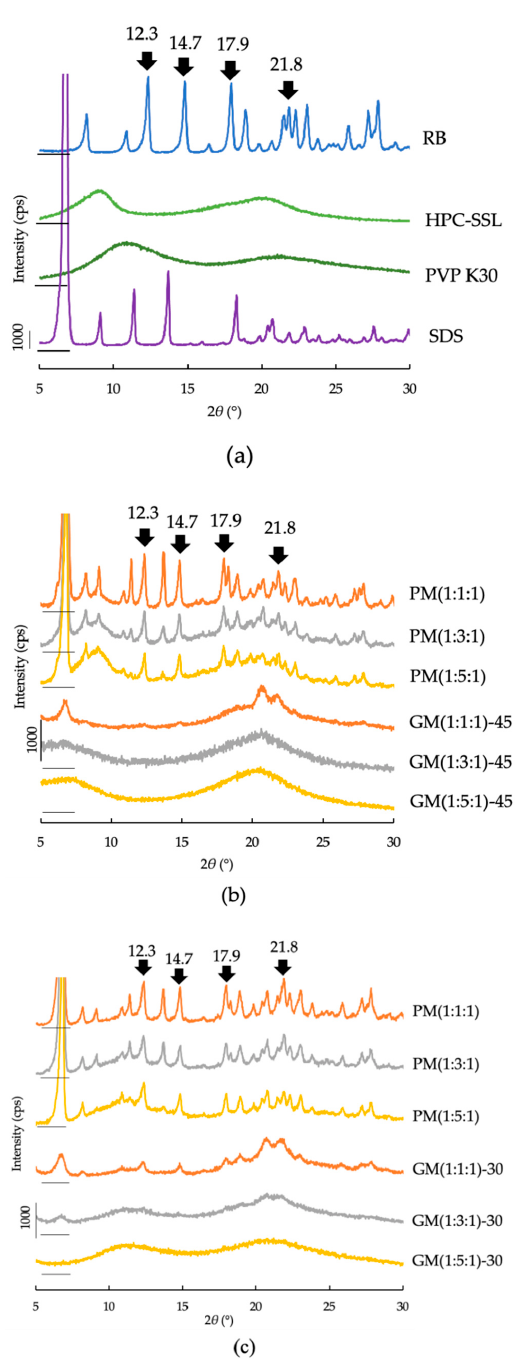
Figure 1. Powder X-ray diffraction (PXRD) patterns of samples. Black arrows with numbers show characteristic peaks of RB crystals. ( a ) RB crystals, hydroxypropyl cellulose (HPC)-SSL, polyvinylpyrrolidone (PVP) K30, and sodium dodecyl sulfate (SDS); ( b ) physical mixtures (PMs) and ground mixtures (GMs) with HPC-SSL in various mixing ratios (grinding time: 45 min); ( c ) PMs and GMs with PVP K30 in various mixing ratios (grinding time: 30 min).